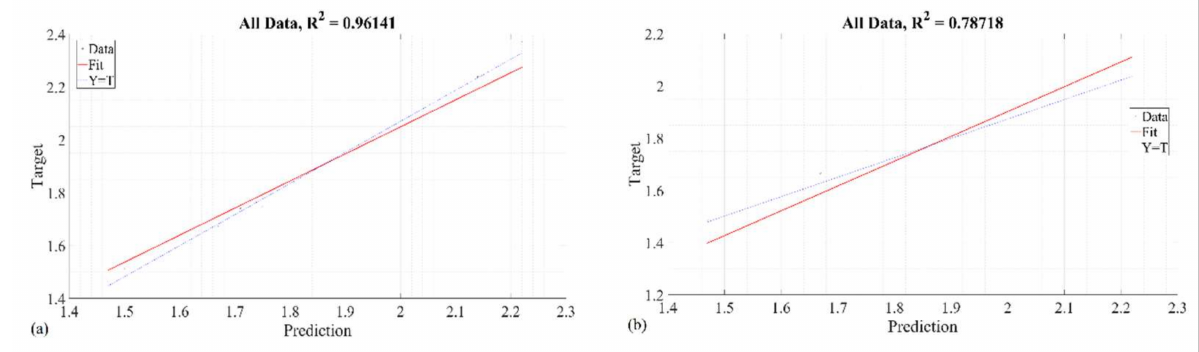
Figure 7. The regression of the data during the testing and training processes for ( a ) ANFIS-SR; ( b ) ANFIS-TW.